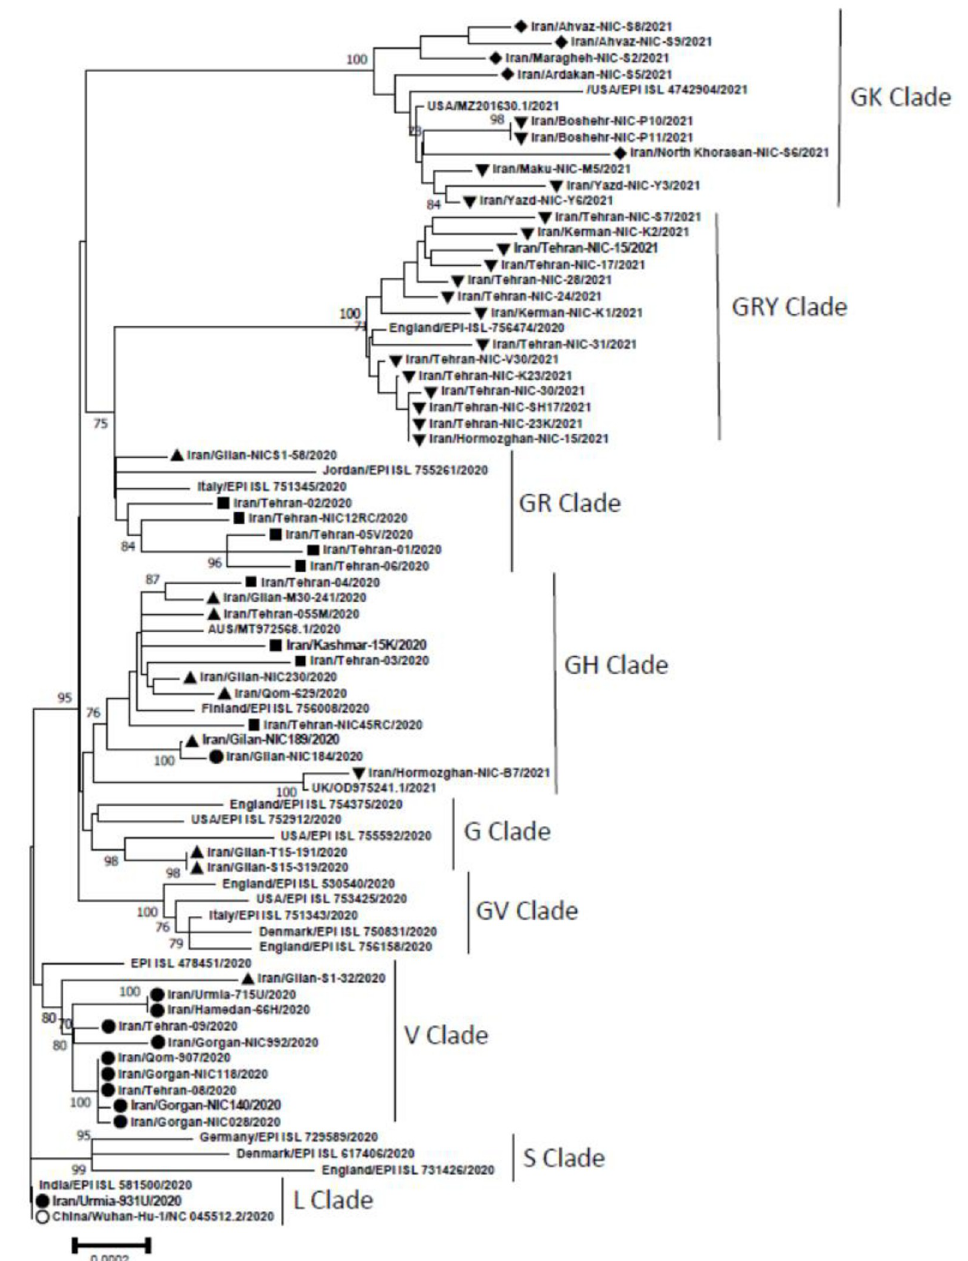
Fig 2. Phylogenetic tree of SARS-CoV2 full-length genomes constructed by MEGA 7. The Neighbor joining method was used with 1,000 bootstrap replicates. The tree contains 54 SARS-CoV2 sequences of these study compared to the reference sequence from GISAID and some other sequences from each clade. In this tree the reference sequence is marked by white circle and sequences of this study were marked as follow: The 1st wave black circle, the 2nd wave inverted black triangle, the 3rd wave with black square, the 4th wave with black triangle and the 5th wave with black diamond.